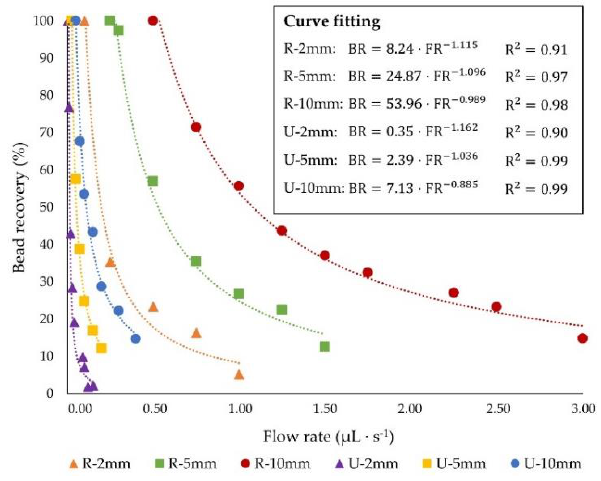
Figure 5. Magnetic bead capture as a function of fluid flow rate for all of the studied geometries.